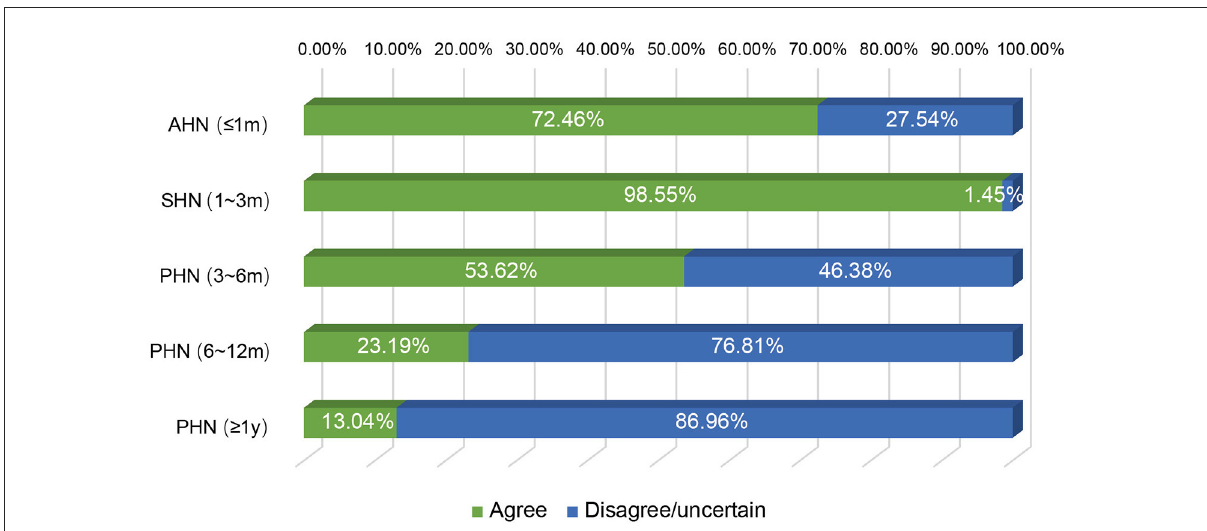
FIGURE5 The indication of st-SCS for HN. Almost all (68/69, 98.55%) experts agreed that the st-SCS can be used in SHN patients, there was a common agreement (72.46%) that AHN patients are an indication of st-SCS and more than half agreement (53.62%) that st-SCS may be fit for early PHN (3–6 months). However, the majority (76.81 and 86.96%) of experts disagreed that PHN patients with more than 6 months and 1-year history should be considered as an indication of